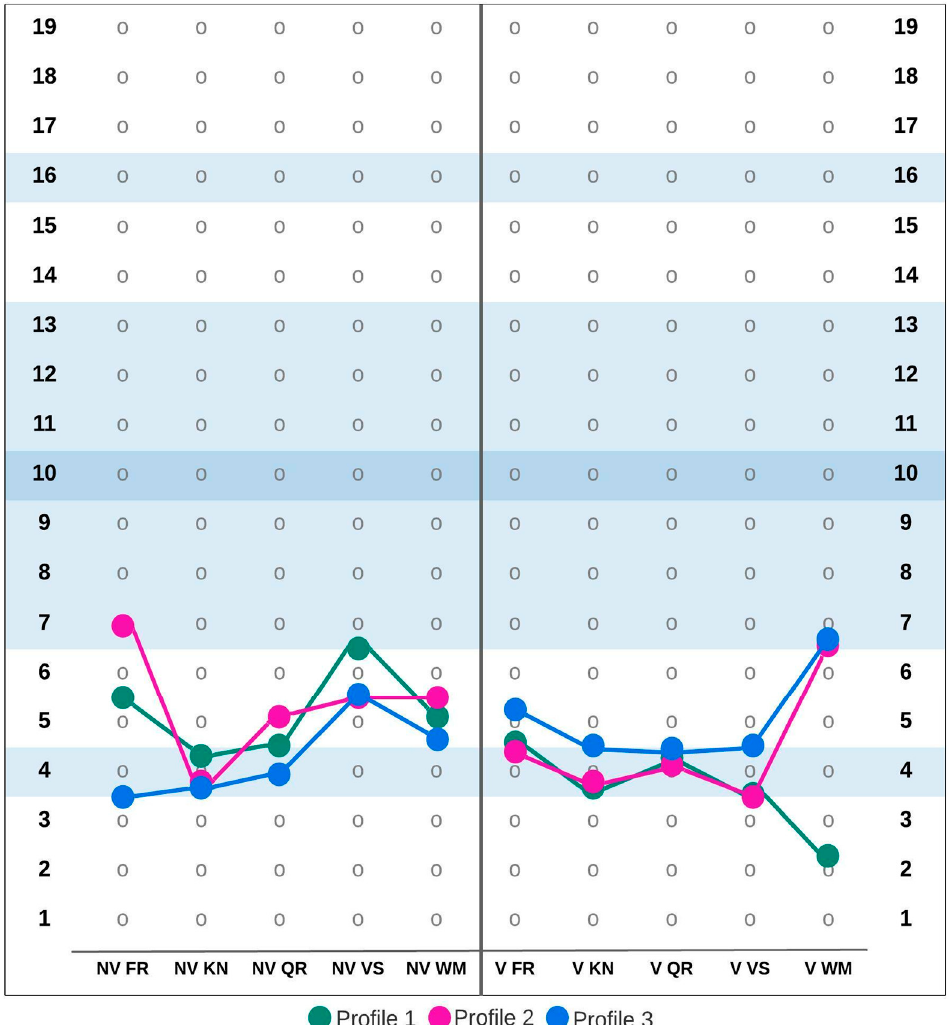
Figure 3. Mild intellectual disability cognitive profiles in the 15;00–18;11 age group. Abbreviations: NV FR—Nonverbal Fluid Reasoning, NV KN—Nonverbal Knowledge, NV QR—Nonverbal